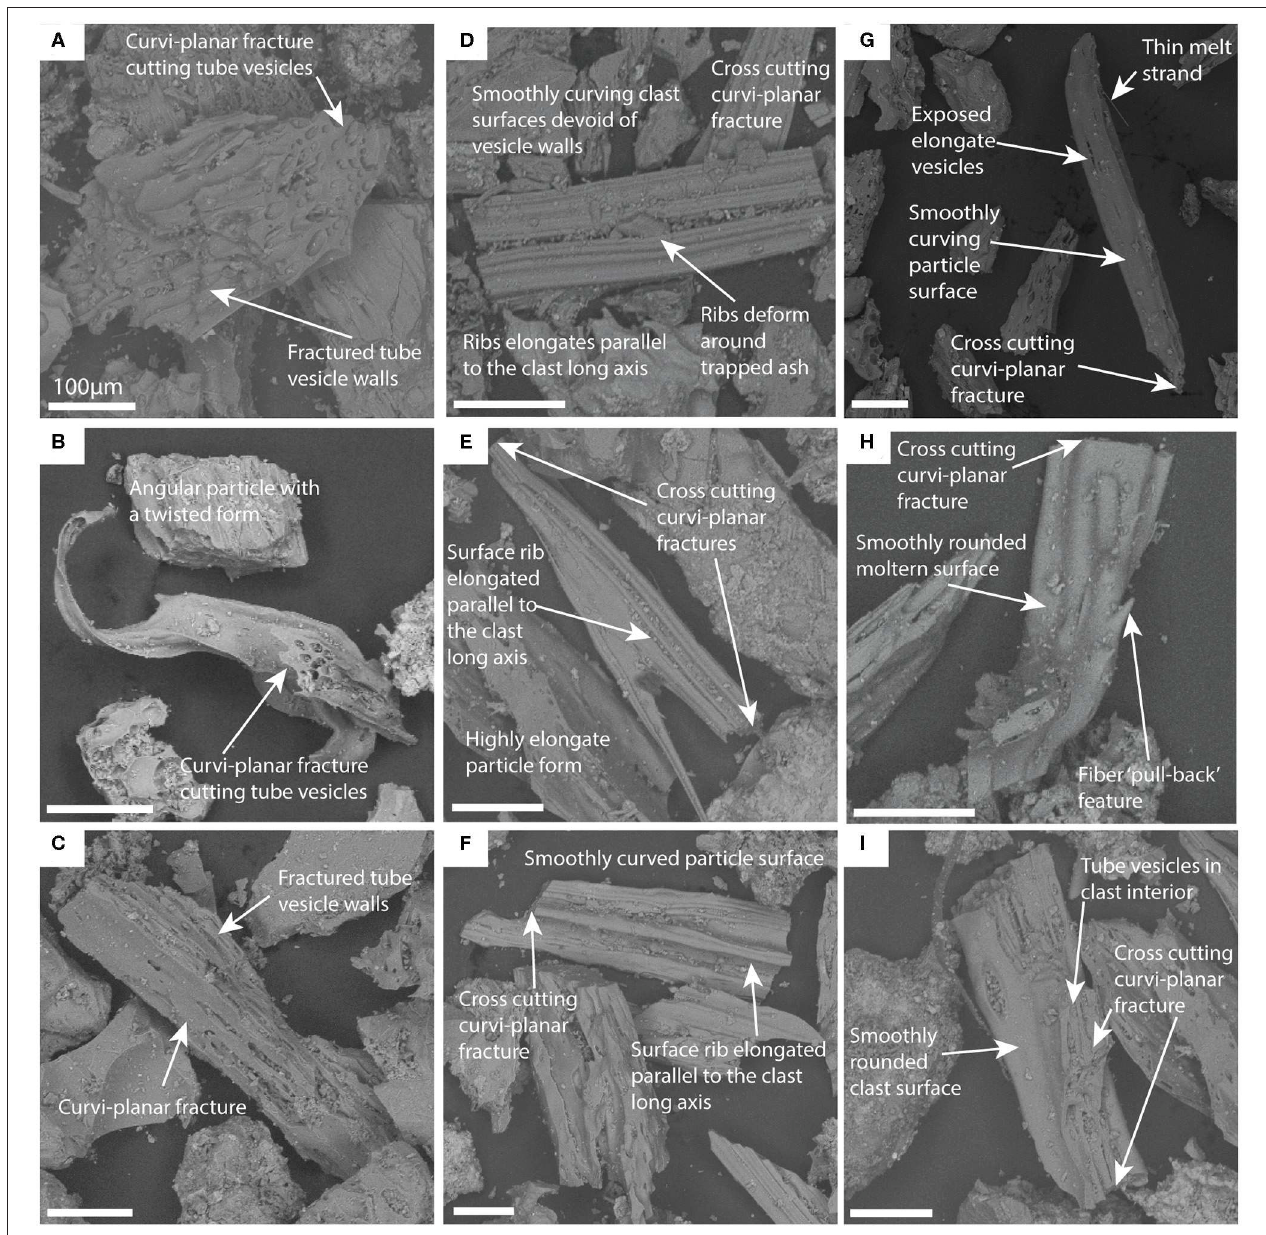
FIGURE 5 | SEM SE images showing elongate tube-angular (A–C) , -ribbed (D–F), and -fluidal particles (G–I) from a range of samples; HVR070— (A,D,I) ; HVR031— (B) ; HVR159— (C) ; HVR283— (F,H ); HVR163— (E) ; HVR105— (G) . Grains from each componentry class show features associated with that class. Elongate tube-angular particles show brittle fractured bubble walls crosscut by curvi-planar fracture surfaces (A–C) . (C) Particle with a twisted shape. Elongate tube-ribbed particles are varied, with ribs that may not extend the full particle length (E) and variable spacing (F) . Fluidal grains show a wide range of features including drips and pull-back features (G–I) , and evidence of ductile necking (I)